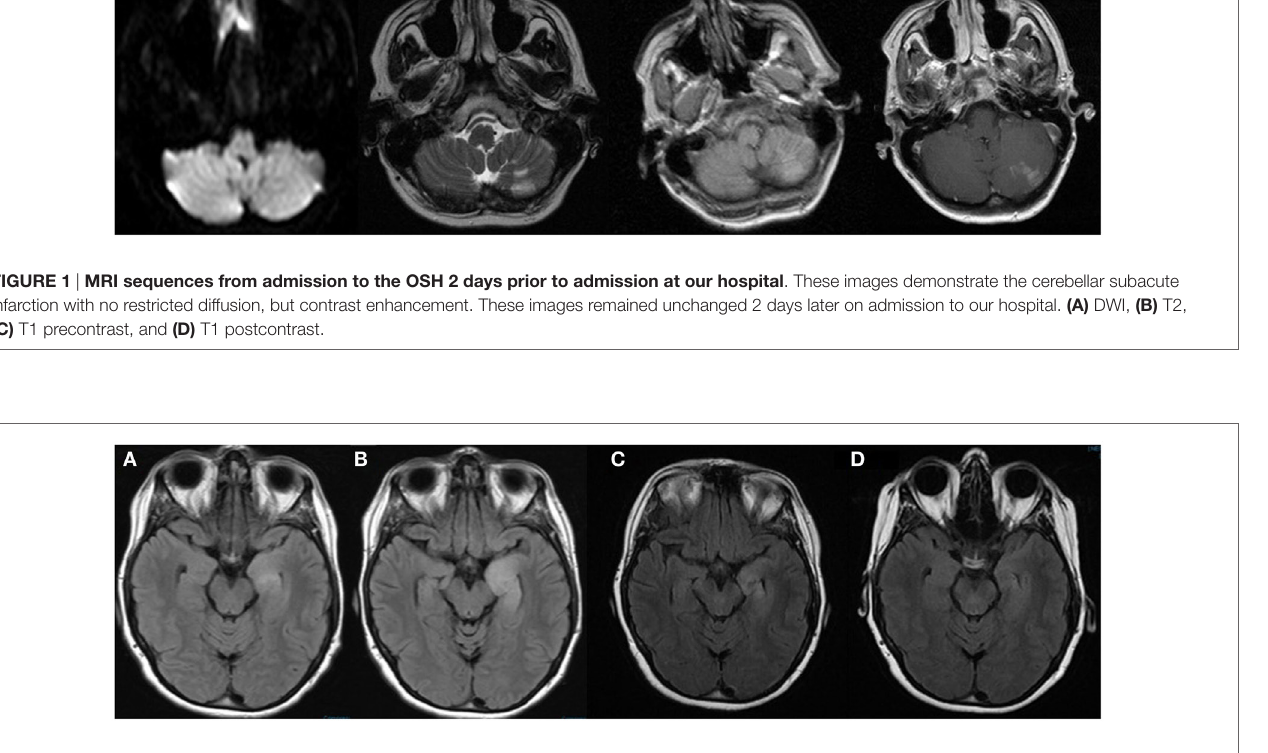
FIGURe 2 | MRI brain FLaIR sequences performed on admission to our hospital (a), 7 days after admission (B), 1 month after discharge (C), and 4 months after discharge (D) . These images demonstrate the evolution of the left mesial temporal lobe lesion during admission and improvement 1 month and 4 months after discharge.